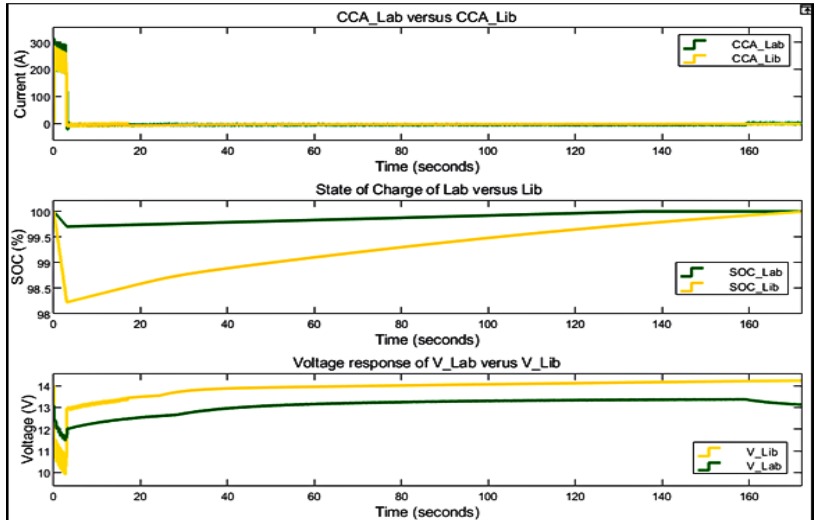
Figure 12. CCC contribution, SoC and voltage response of HESS during discharging and charging modes for case two (a).